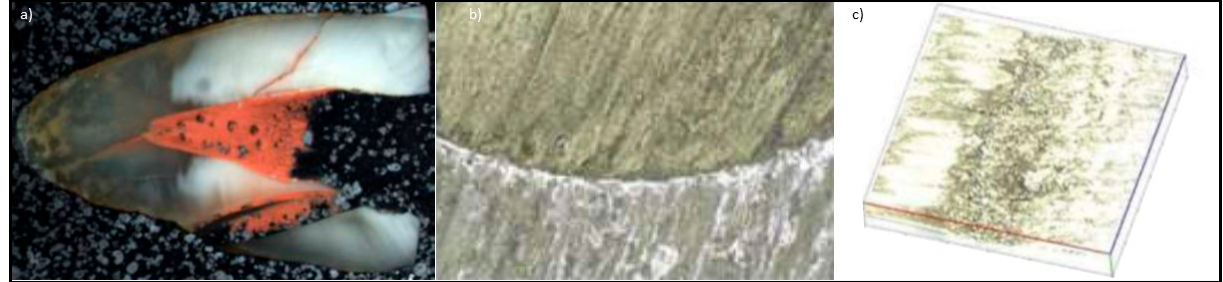
Figure 19. ( a ) View of the specimen made on the ISOTOM cutter and embedded in the polymer resin, viewed with LSM; ( b ) tight connection of the three layers of material based on gutta-percha coated with sealant and root dentin; ( c ) 3D visualization from ( b ), viewed with a laser confocal microscope (LCM).